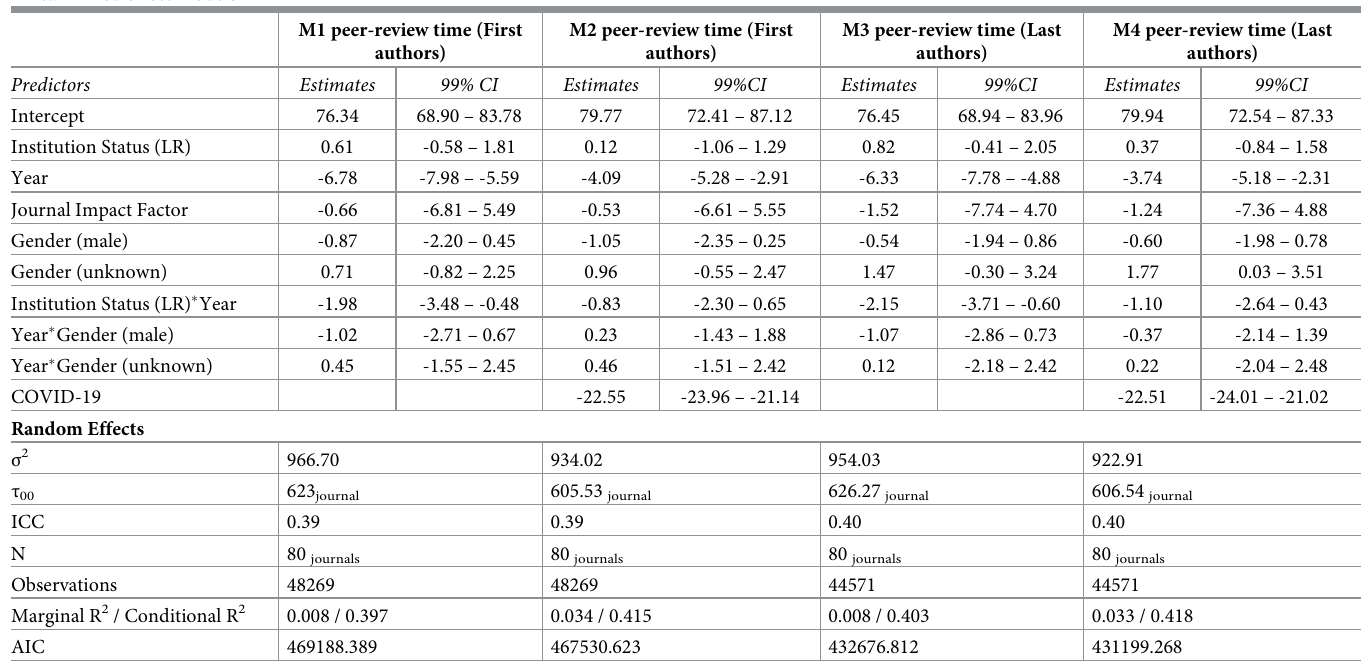
Table 1. Mixed linear regression models predicting the change in peer-review duration from 2019 to